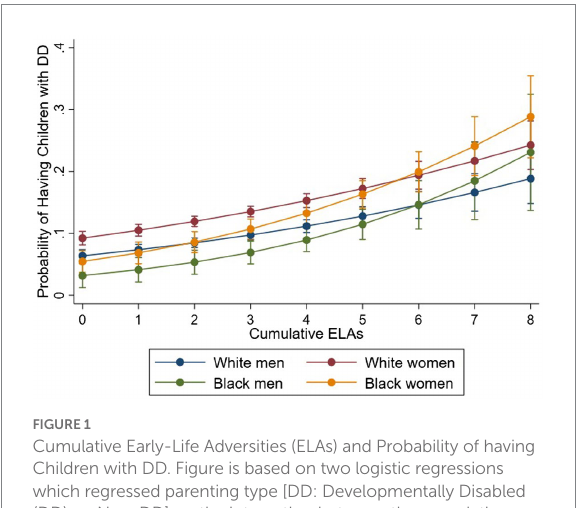
FIGURE 1 Cumulative Early-Life Adversities (ELAs) and Probability of having Children with DD. Figure is based on two logistic regressions which regressed parenting type [DD: Developmentally Disabled (DD) vs. Non-DD] on the interaction between the cumulative ELAs and race–gender groups, controlling for age and sample.